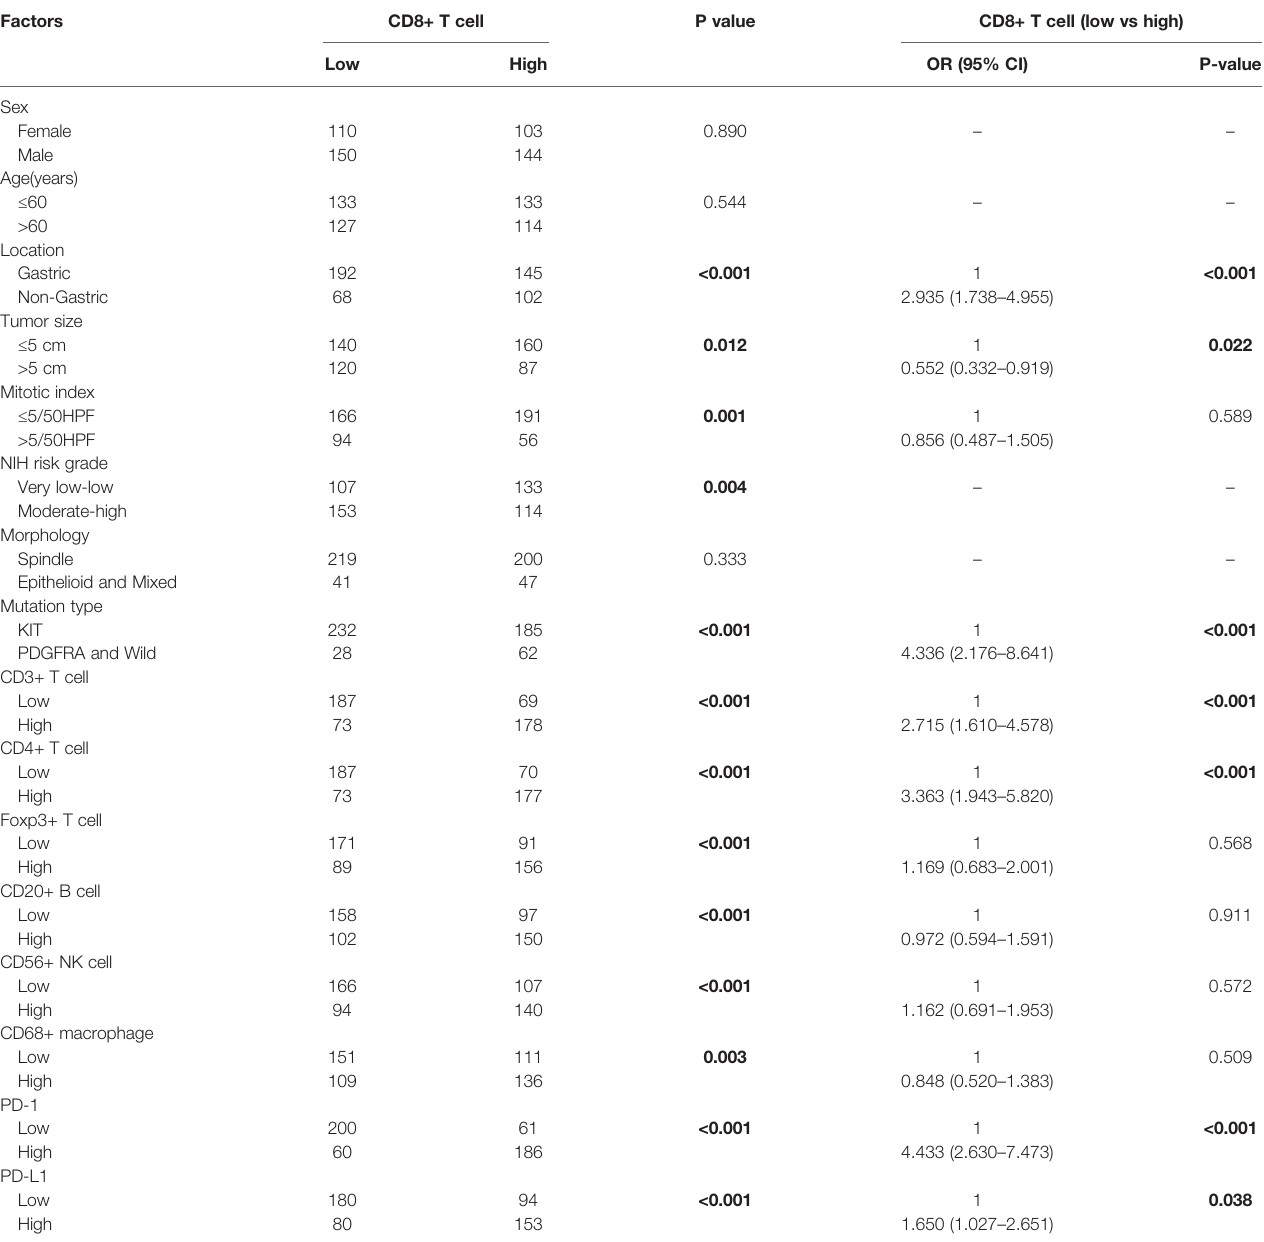
TABLE 2 | Relationship between CD8+ T cells and clinicopathological